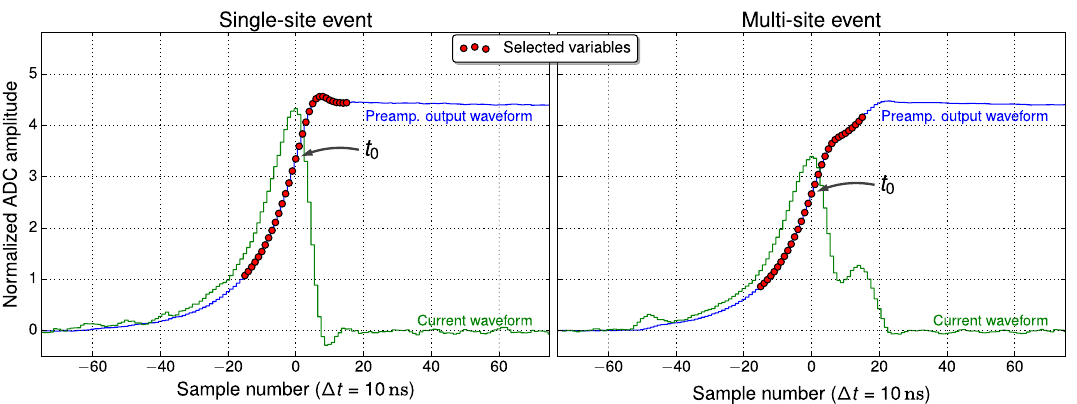
Fig. 3 Pulse shapes from typical single-site (left) and multi-site (right) events. The current pulses (in green) were obtained by digital differenti- ation of the preamplifier output (in blue) and smoothing with a moving